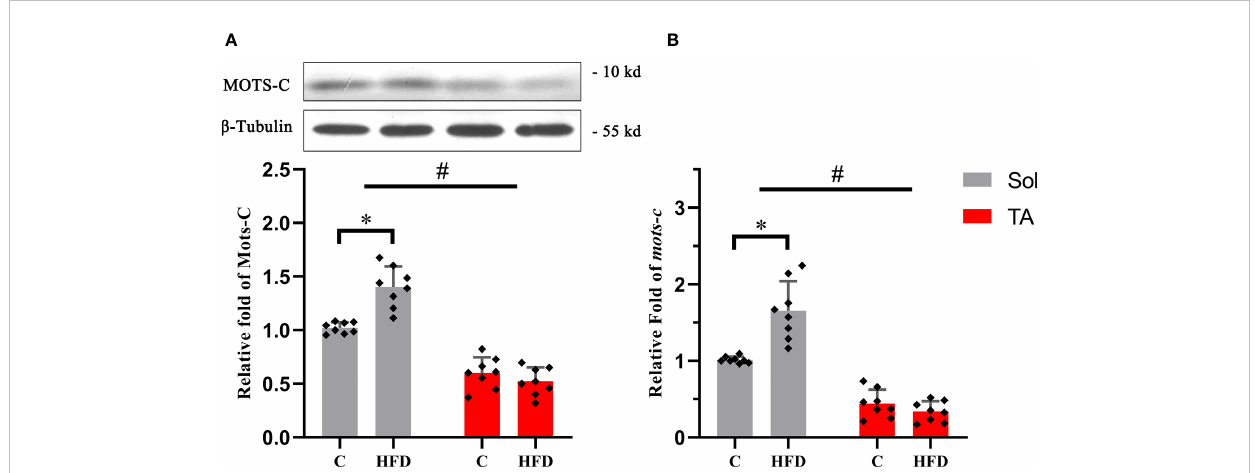
FIGURE 5 The relative protein and mRNA expression levels of MOTS-c in slow- and fast-twitch muscles among all groups. (A) The protein expression level of MOTS-c in the Sol and TA muscles among the groups. (B) Relative fold change in MOTS-c mRNA levels in the Sol and TA muscles among the groups. (*p<0.05 and #p<0.05 when comparison was conducted between muscles; n=8 for each